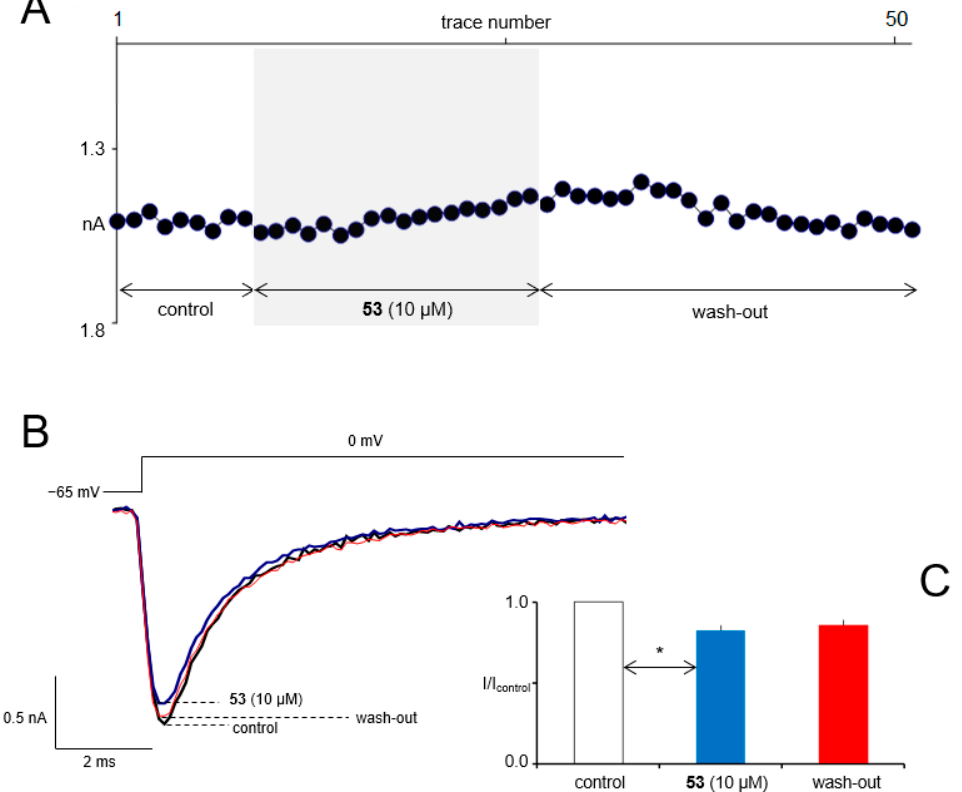
Figure 5. ( A ) The influence of compound 53 on sodium current is shown on an example neuron. The current was evoked once every ten seconds by a rectangular voltage-step. Vertical axis shows the maximal current amplitudes (black circles) in the control, in the presence of 53, and after wash-out. The horizontal axis shows the trace number. ( B ) Example of the sodium current recordings in the control (black trace), after the application of the tested compound (blue trace), and after wash-out (red trace). ( C ) The averaged normalized maximal current amplitudes in the control, in the presence of 53, and after wash-out. The data were analyzed with a nonparametric repeated measures ANOVA followed by Dunn’s post hoc test. * p < 0.01 ( n = 7).